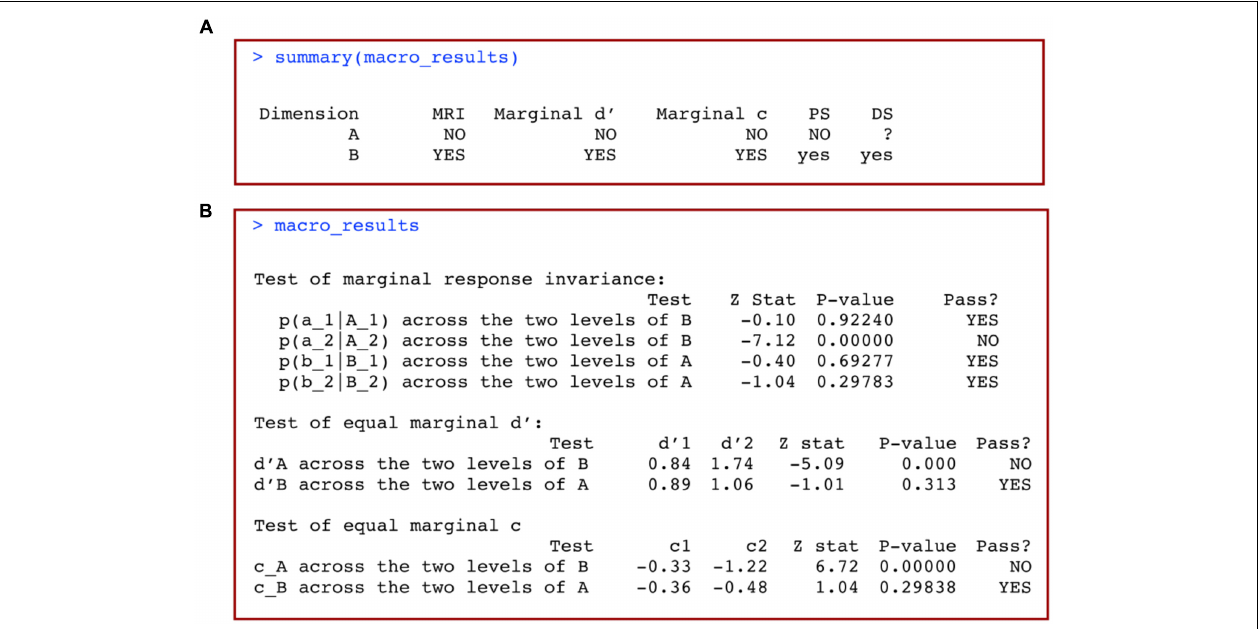
FIGURE 4 | (A) Summary and (B) full results of a macro-analysis of data from a 2 × 2 identification design with grtools